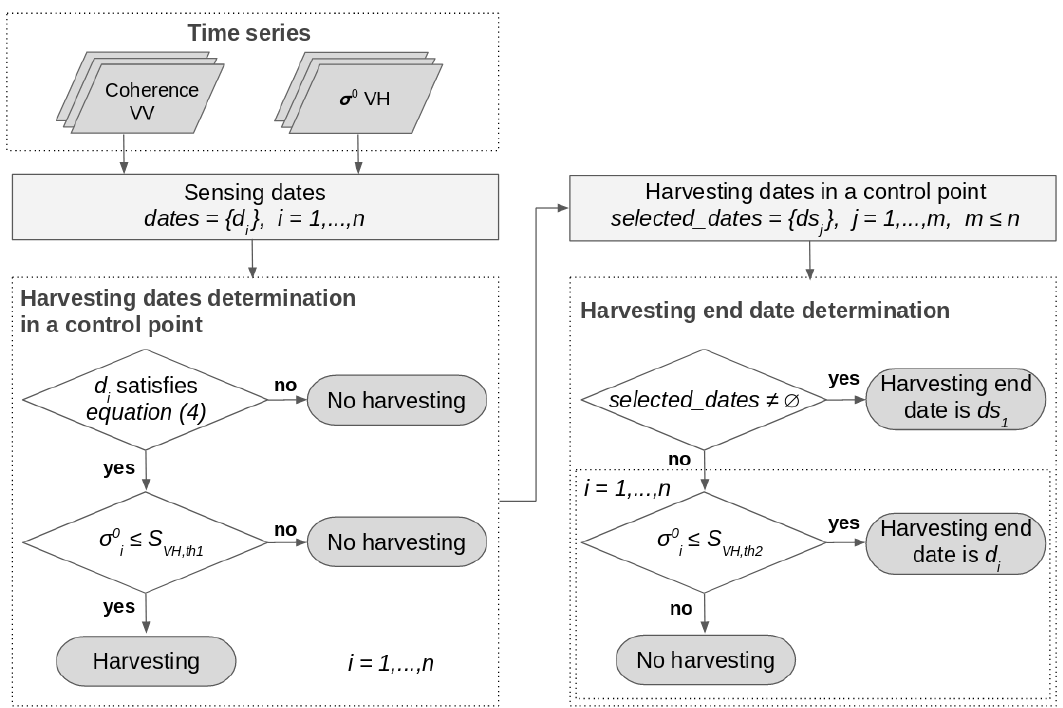
Figure 9. Flowchart of harvesting date determining for a control